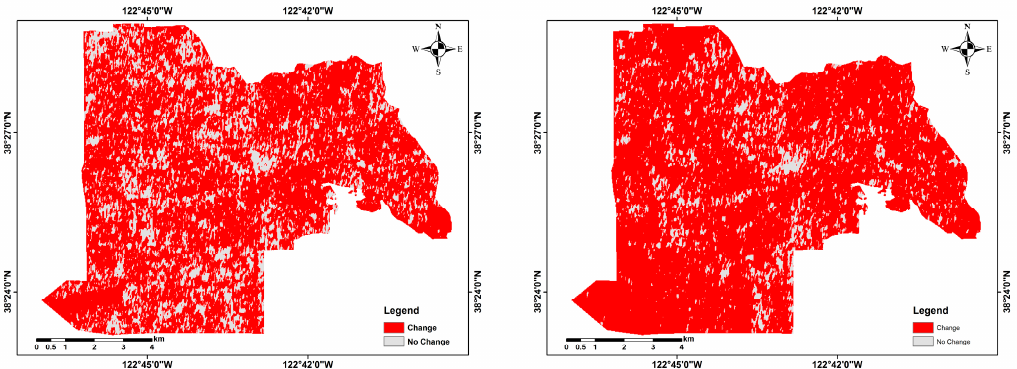
Figure 5. Santa Rosa Coherence image classified into change and no change showing images before (22 August 2017, left ) and after (14 November 2017, right ) the fire disaster event.